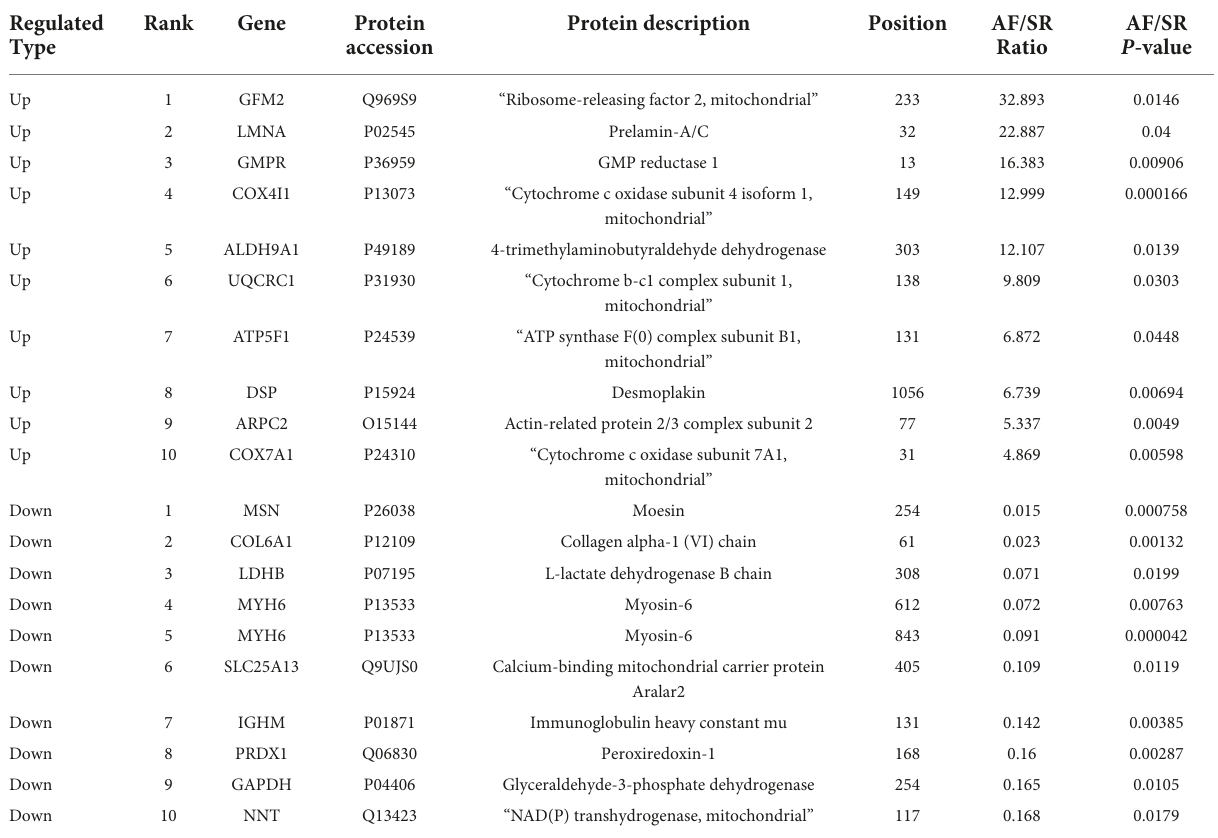
TABLE 2 Top 10 upregulated and downregulated Kac sites in Kac proteins in the AF group. Regulated